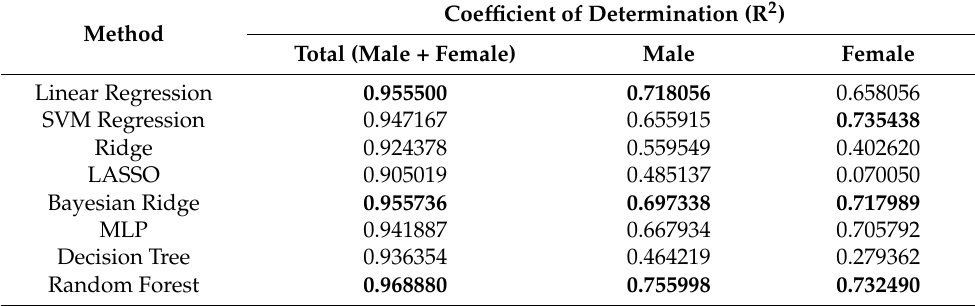
Table 2. Show the mean square error.